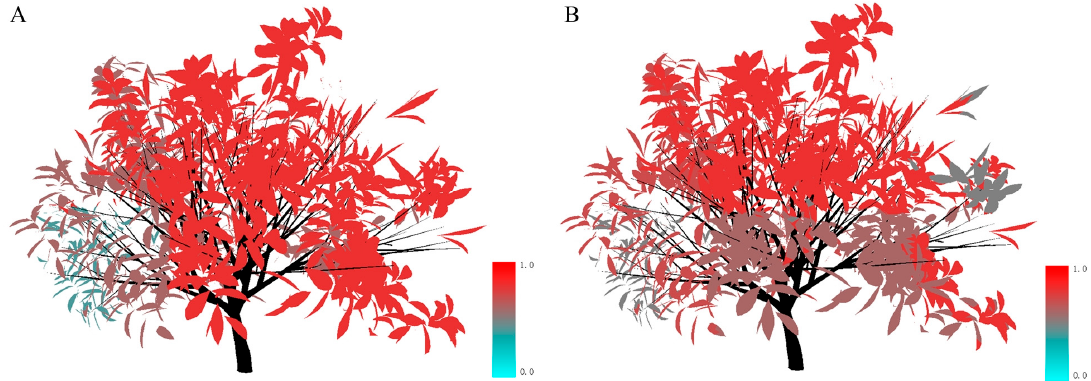
Figure 10. The STAR value distribution within the virtual loquat canopy on June 21, 2016. Warmer colors denote a higher STAR value, whereas cooler colors denote lower STAR values. ( A ) 10:00 and ( B ) 12:00.